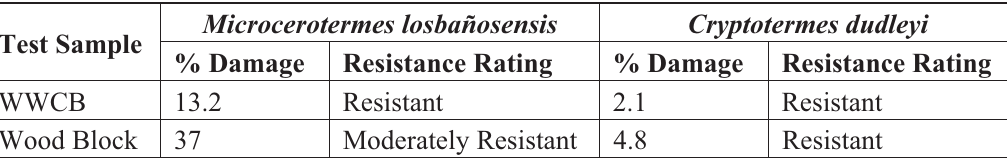
Table 2. Mean termite damage in WWCBs and G. arborea wood blocks exposed to M. losbañosensis and C. dudleyi